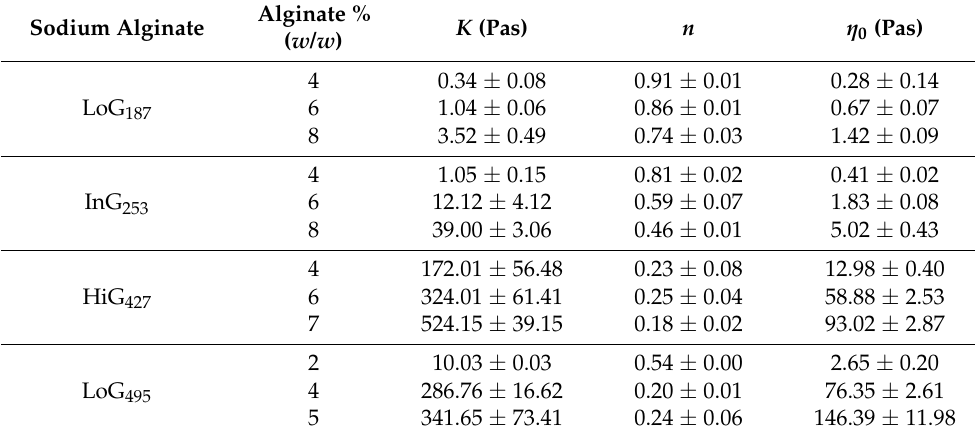
Table 3. Ostwald–de Waele parameters and zero-shear viscosity for all sodium alginates in aqueous solution at different concentrations and 23 ◦